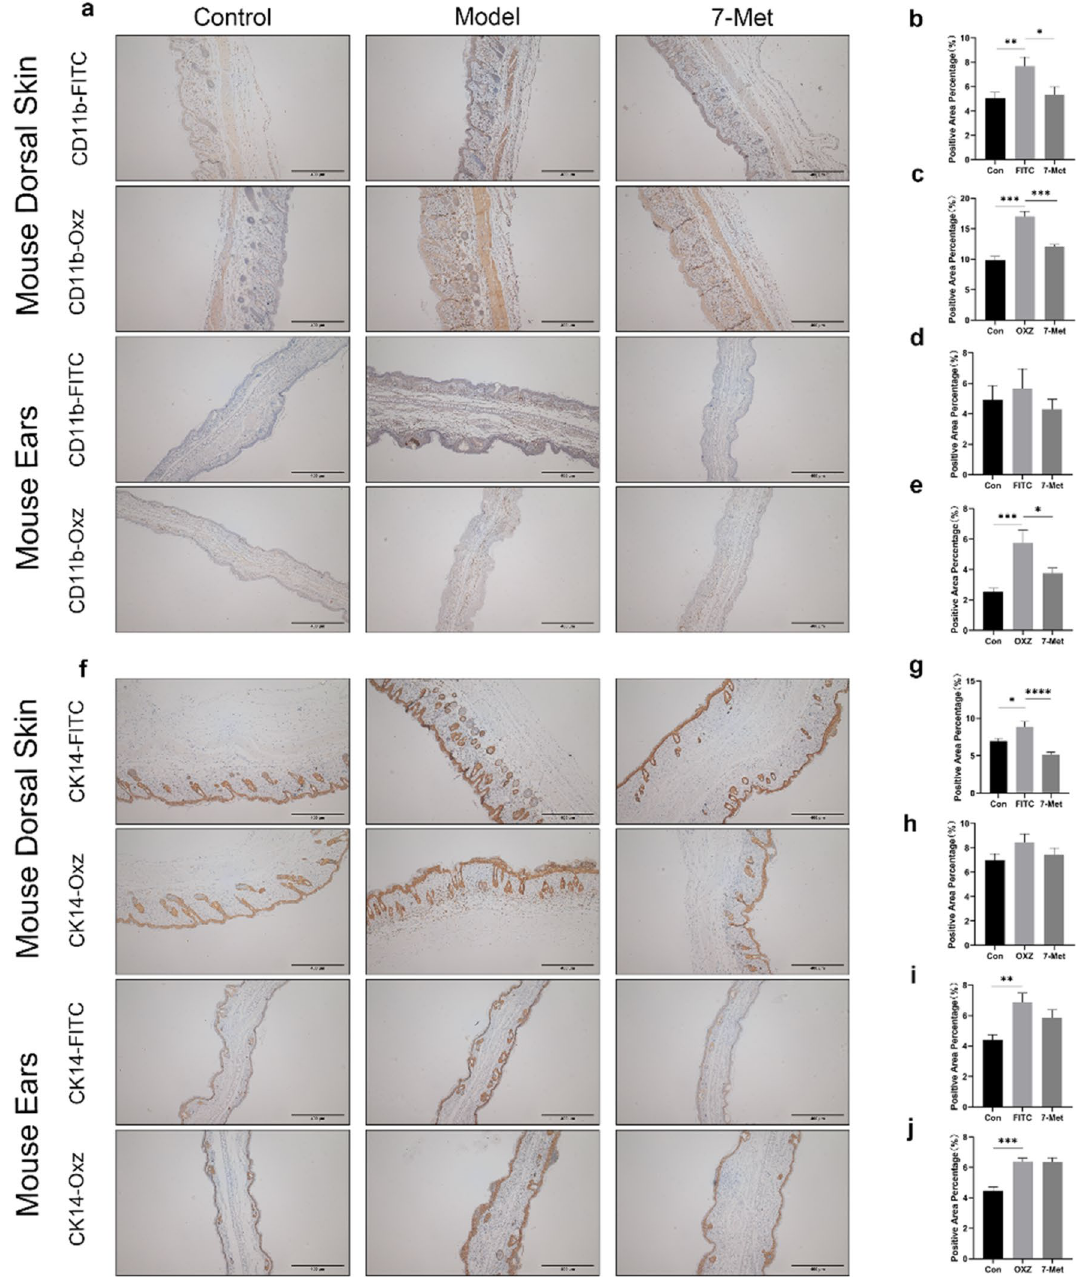
Figure 3. Regulatory effects of drugs on neutrophils, macrophages and keratinocytes in AD mice. ( a) Representative CD11b immunohistochemistry-stained (scale bar = 400 μm) cross sections of ears and dorsal skin. ( b ) The quantitative analysis of positive area in mouse dorsal skin treated by FITC or 7-Met was carried out using ImageJ software. Values are expressed as the means ± S.E.M. (n = 3). (p Model = 0.0072, p 7-Met = 0.0126). ( c ) The quantitative analysis of positive area in mouse dorsal skin treated by OXZ or 7-Met was carried out using ImageJ software. Values are expressed as the means ± S.E.M. (n = 3). (p Model < 0.0001, p 7-Met < 0.0001). ( d ) The quantitative analysis of positive area in mouse ears treated by FITC or 7-Met was carried out using ImageJ software. Values are expressed as the means ± S.E.M. (n = 3). ( e ) The quantitative analysis of positive area in mouse ears treated by OXZ or 7-Met was carried out using ImageJ software. Values are expressed as the means ± S.E.M. (n = 3). (p Model = 0.0003, p 7-Met = 0.0352). ( f )